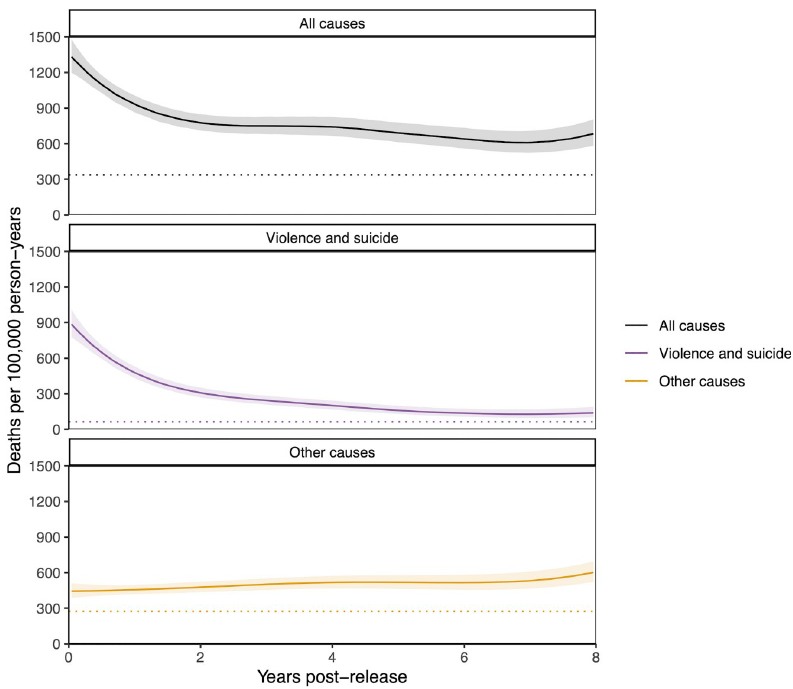
Fig 5. All-cause and violent death rates over time among men following release from prison. Instantaneous crude death rate among formerly incarcerated men for all causes of death (black), violence and suicide (purple), or causes other than violence and suicide (yellow). Bands indicate the 95% CI. The dotted horizontal line indicates the age- standardized mortality rate among non-incarcerated male residents of Mato Grosso do Sul, standardized to the age structure of the formerly incarcerated population. CI, confidence